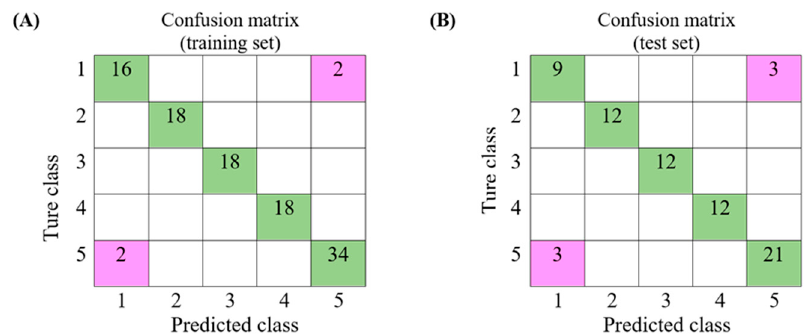
Figure 5. Confusion matrix of the first model that used to discriminate co ff ee from adulterated co ff ee for ( A ) training set and ( B ) test set (class 1—co ff ee; class 2—soybeans; class 3—green mung beans; class